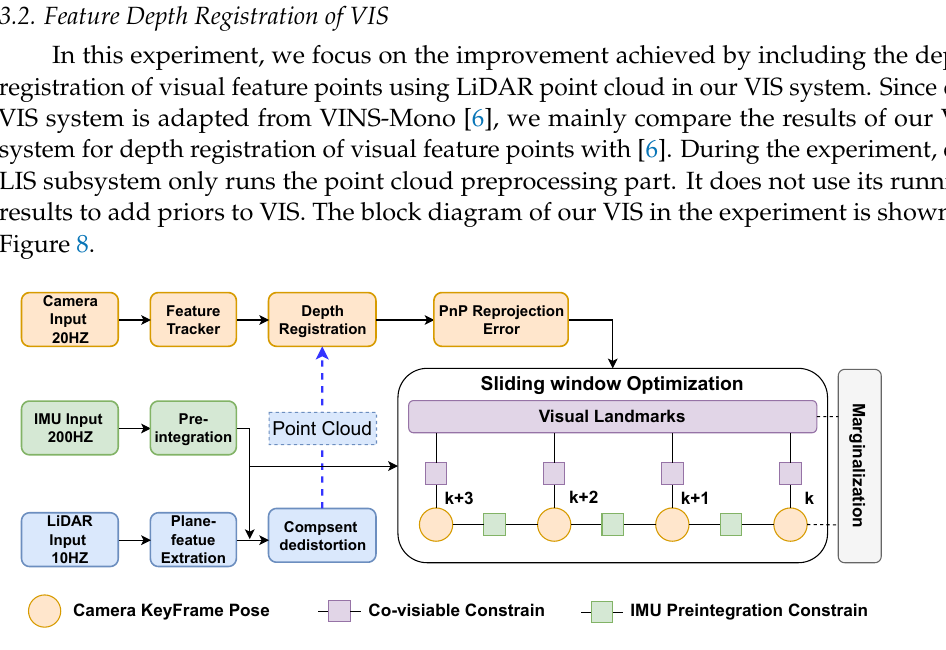
Figure 8. The block diagram of our VIS